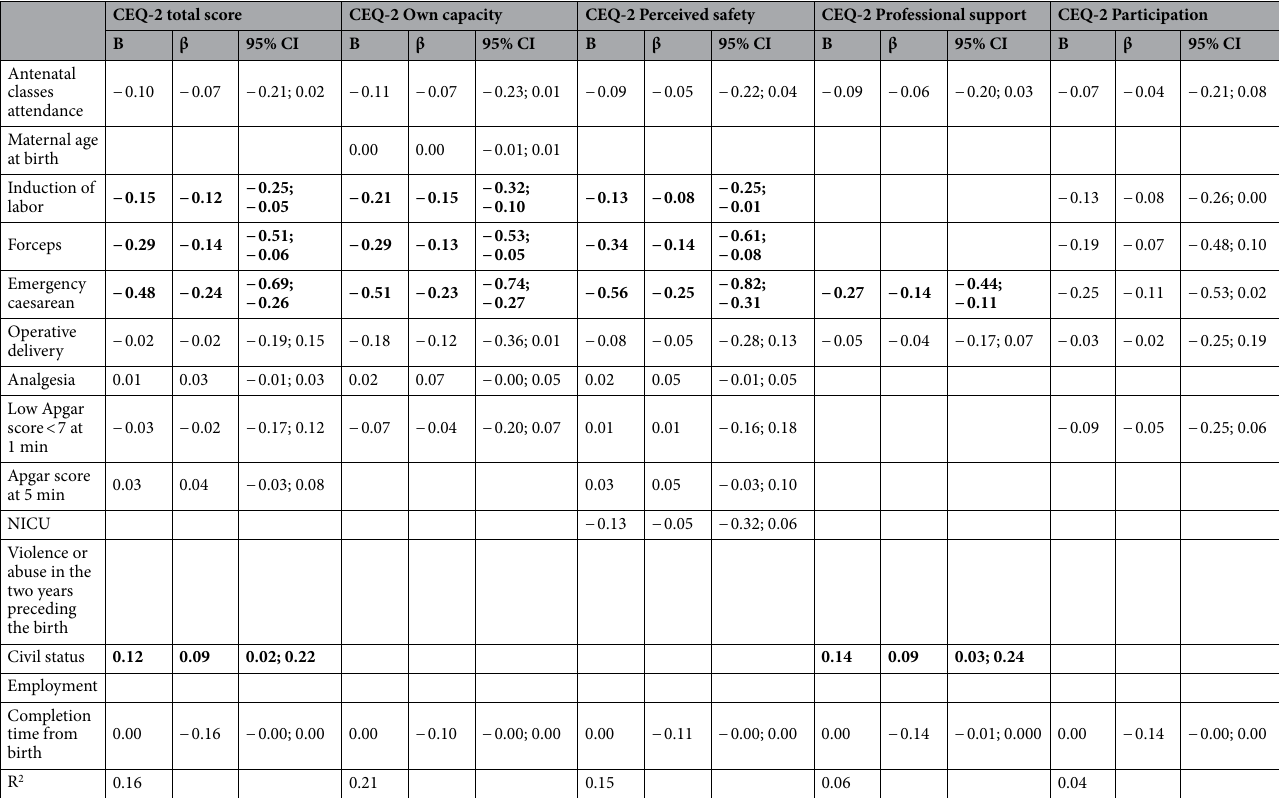
Table 4. Results of multiple linear regression analyses for variables predicting CEQ-2. B = unstandardized regression coefficient; β = standardized regression coefficient; 95% CI = 95% bias corrected and accelerated confidence intervals of unstandardized regression coefficient as estimated by means of bootstrapping. Bold regression coefficients are significantly different from 0 ( p < .05). CEQ-2 = Childbirth Experience Questionnaire